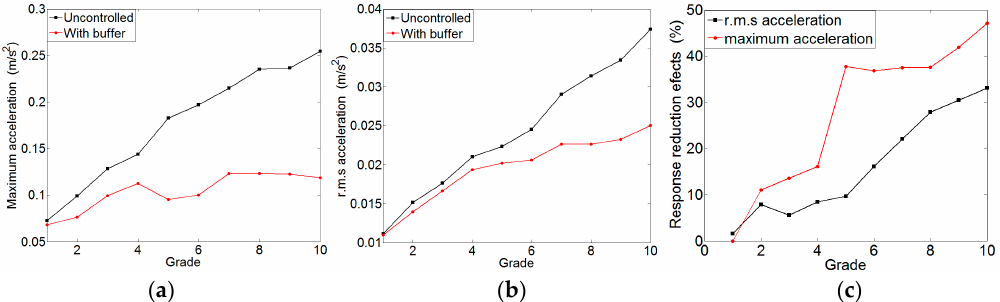
Figure 5. Acceleration response and the reduction efficiency: ( a ) Maximum acceleration; ( b ) Root mean square (r.m.s) acceleration; ( c ) Response reduction effects.